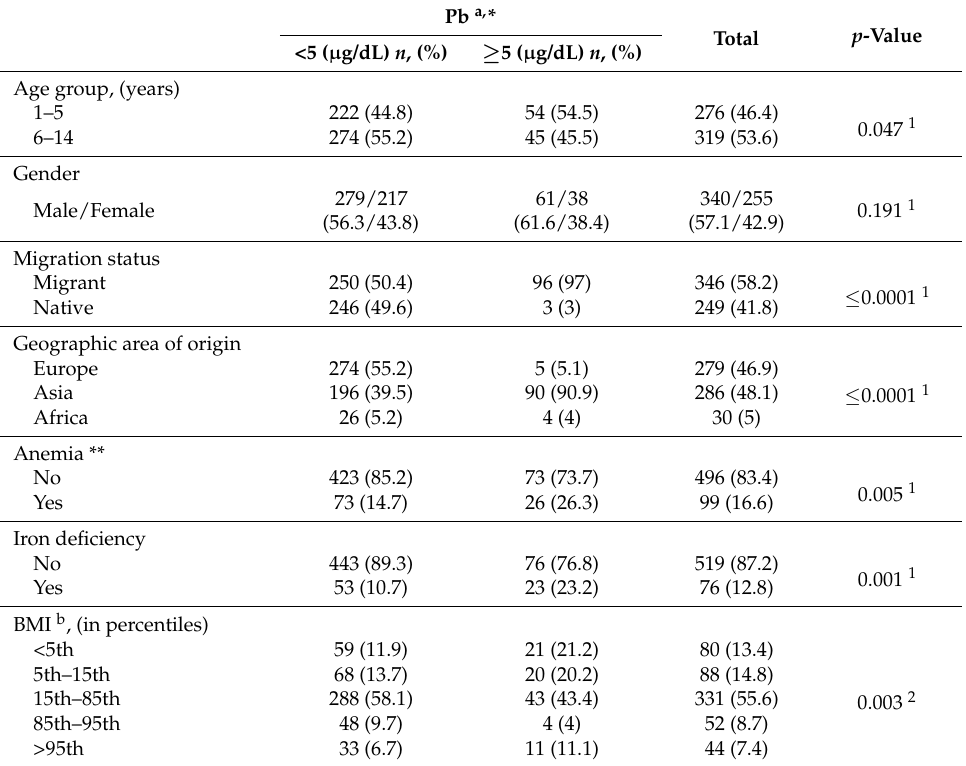
Table 2. Blood lead levels (BLLs) in migrants and native